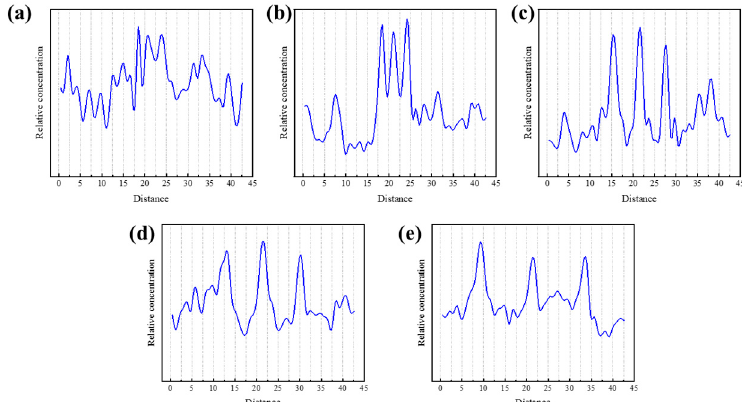
Figure 10. Axial density distribution of FGO/F ‐ EP composites with different distribution characteristics. ( a ) Random; ( b ) 3 ‐ FGO/F ‐ EP; ( c ) 6 ‐ FGO/F ‐ EP; ( d ) 9 ‐ FGO/F ‐ EP; ( e ) 12 ‐ FGO/F ‐ EP.